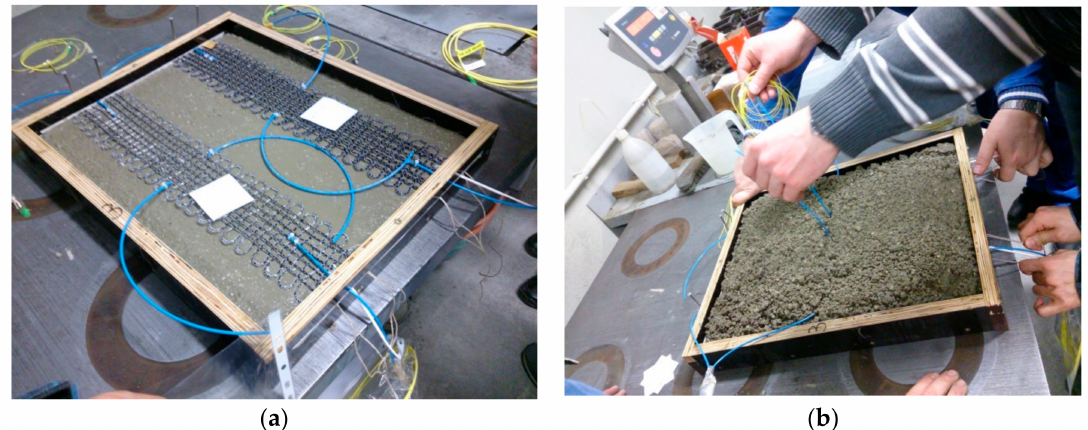
Figure 3. Embedding FCS in concrete; ( a ) Two FCSs with dimensions of 500 × 110 mm 2 were fixed in a 500 × 400 × 40 mm 3 mould; ( b ) Plastic tubes applied to protect fiber from breackage at the FCS/concrete interface. The FBGs are positioned at the centre of the FCS.